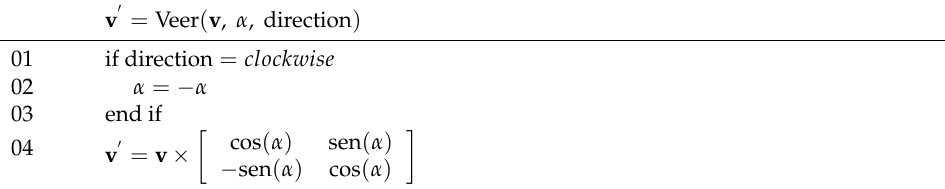
Table 5. Velocity vector direction change.